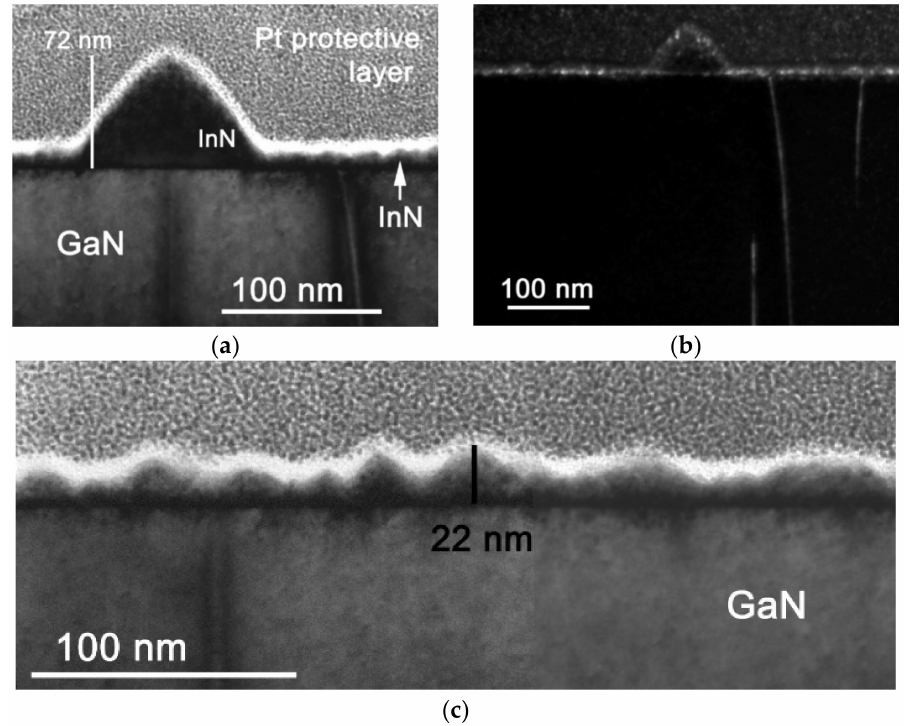
(cid:2) (cid:3) 1210 InN direction. Bright